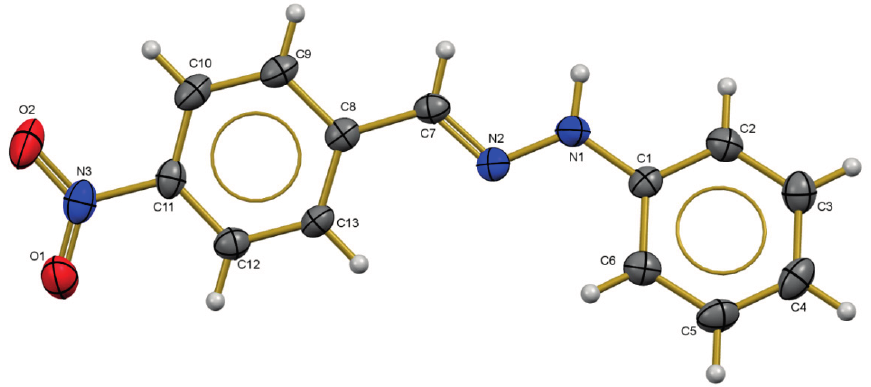
Figure 6. Crystal structure of compound 3 with the thermal ellipsoids drawn at 50%